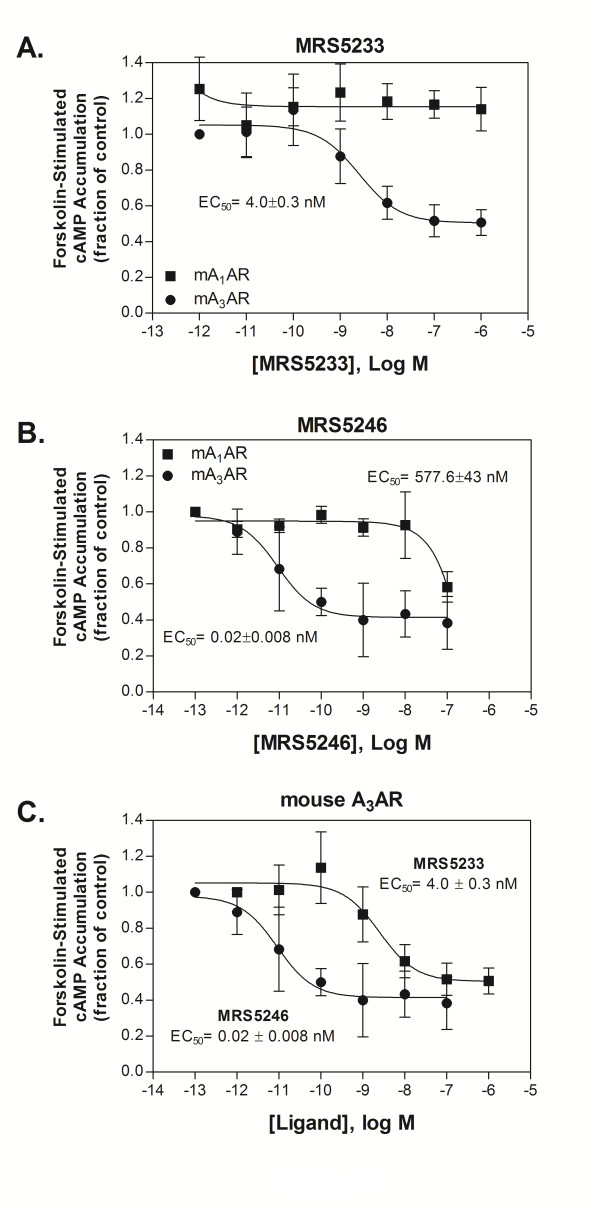
cAMP functional assays. Increasing concentrations of MRS5246 or MRS5322 were added to activate mA1 or mA3ARs to inhibit forskolin-stimulated cAMP production. A & B, both compounds are much more potent at the mA3AR than at the mA1AR. C, curves from mA3ARs to compare and show MRS5246 was much more potent than MRS5233 at the mA3AR.